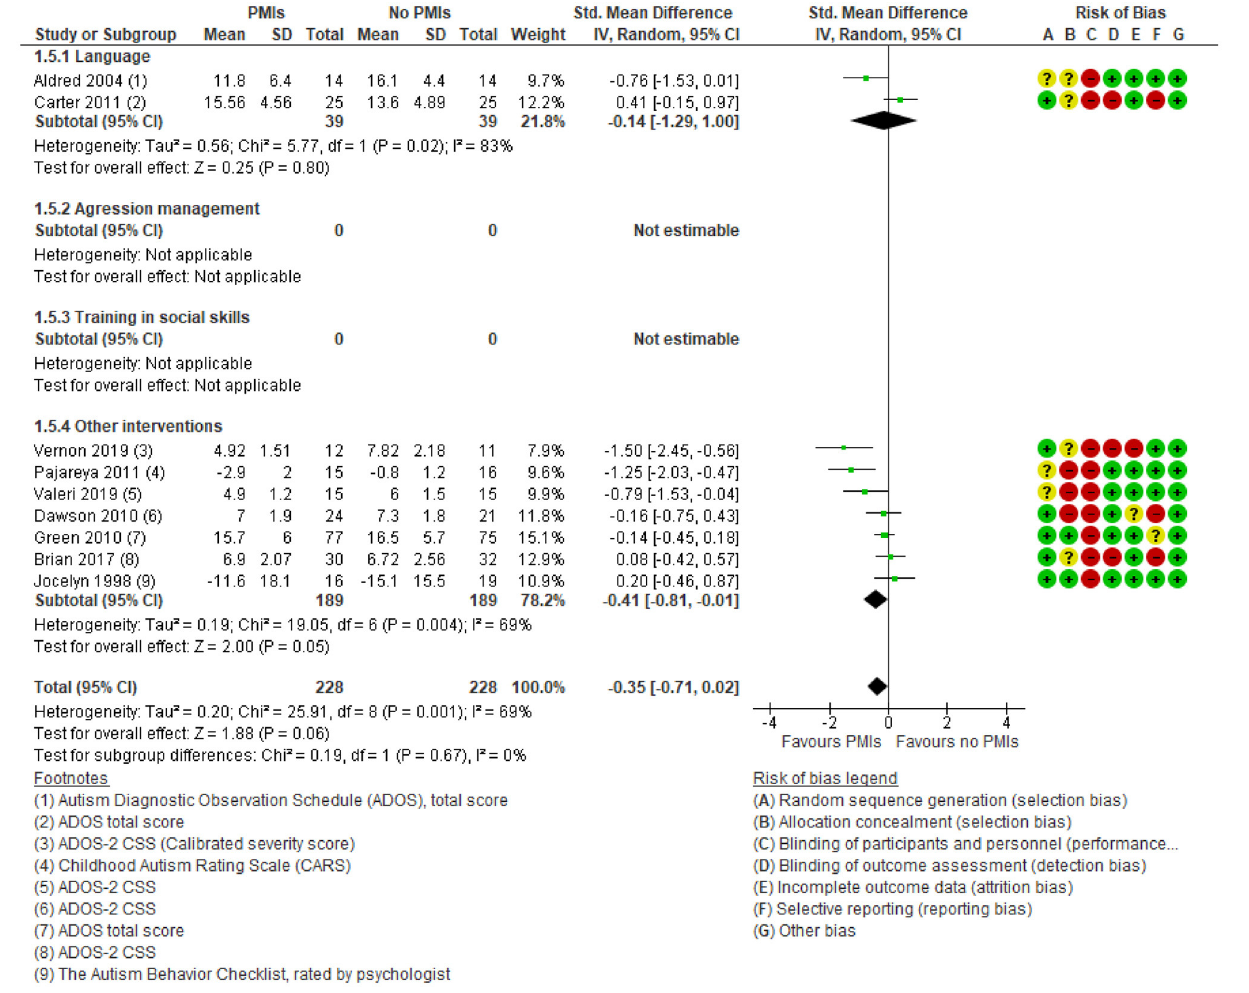
which was not among the prespecified outcomes of this review (10, 15,